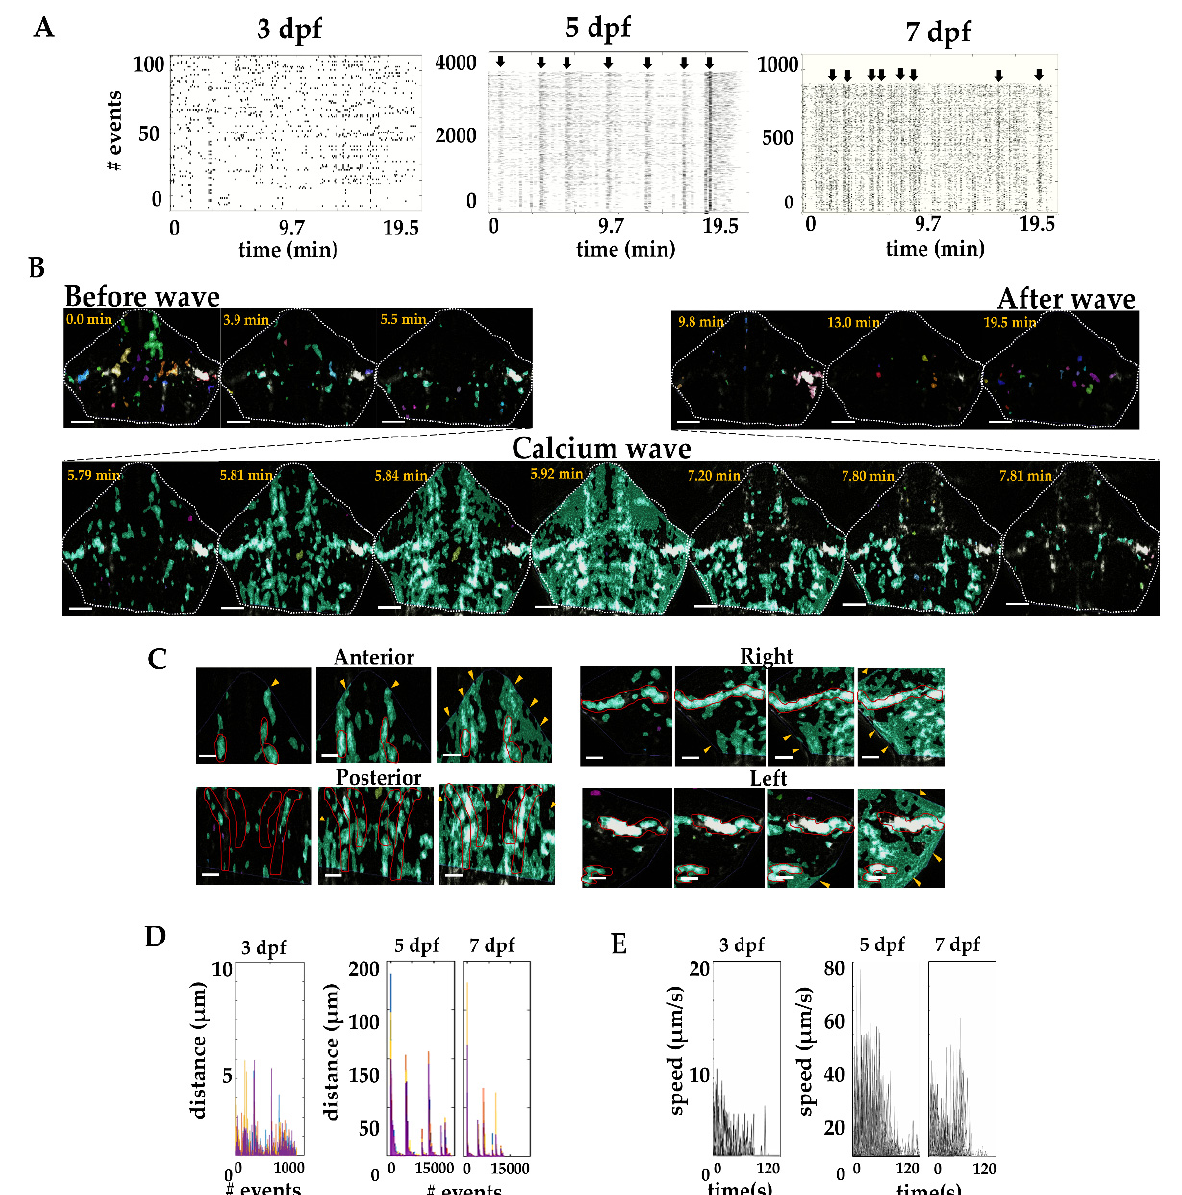
Figure 4. Calcium waves in the cerebellum. ( A ) Calcium events at 3, 5, and 7 dpf (each region of interest is aligned in time and each event is represented by a black dot, black arrows indicate the waves). ( B ) A calcium wave at 5 dpf. The calcium waves spread from the most posterior region of the cerebellum to the anterior region (white dashed line delineates the cerebellum). ( C ) Sample images of calcium activity spreading within radial glia in the lateral regions (left-right) and anterior and posterior regions. Red lines indicate the mid area where the radial glia somas are located, and yellow arrowheads indicate the pial surface where the terminal end-feet of the radial glia are located. ( D ) Spreading distance of calcium waves (as shown in ( A )). At 5 and 7 dpf, only about 2% of the events propagated to form a calcium wave. ( E ) Calcium wave speed at 3, 5 and 7 dpf. 3 dpf, n = 897; 5 dpf, n = 14348; 7 dpf, n = 8848. N = 6 larvae per age. Scale bar 50 and 20 µm.